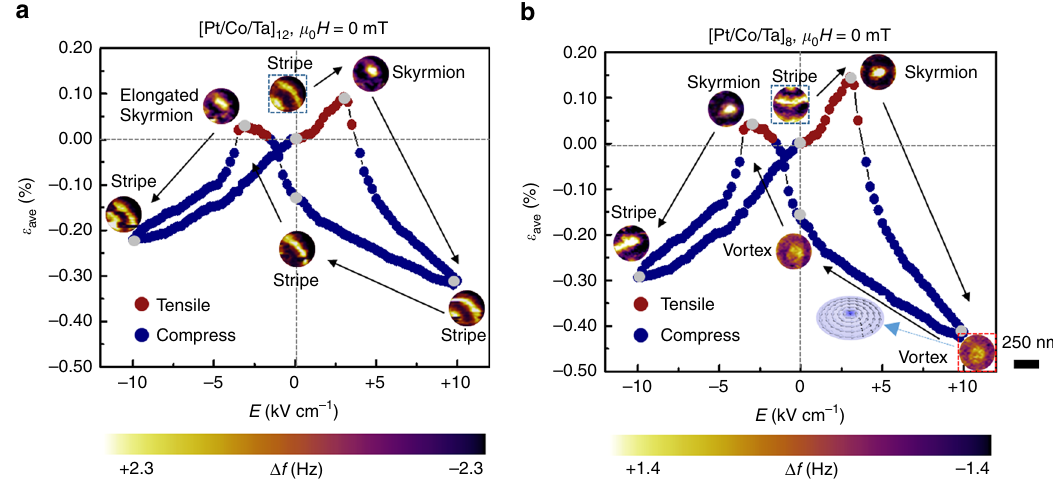
Fig. 2 Electric- fi eld-induced switching of individual skyrmion. The transferred average strain ε ave and corresponding magnetic domain evolution processes in the d ~ 350 nm a [Pt/Co/Ta] 12 and b [Pt/Co/Ta] 8 nano-dots in a cycle of E ranging from + 10 to − 10 kV cm − 1 . Positive ε ave (red dots) represents tensile strain while negative ε ave (blue dots) represents compressive strain. μ 0 H represents the external magnetic fi eld except that from the MFM tip and here μ 0 H is equal to be 0 mT. The inset of b illustrates the spin texture of the magnetic domain that is encompassed by the red box. The stripe domain enclosed by the black box shows the initial state of the magnetic domain evolution path. The gray dots represent the corresponding electric fi eld for the MFM images. The MFM contrast represents the MFM tip resonant frequency shift ( Δ f ). The scale bar represents 250 nm.